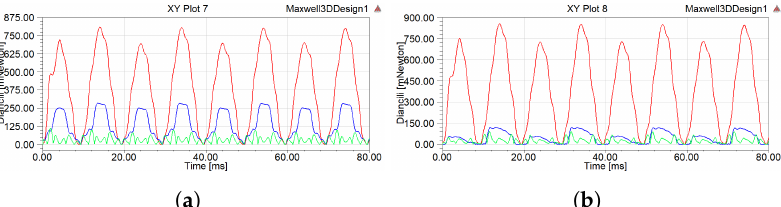
Figure 21. Dynamic response curves of electromagnetic force on each winding under working condition 3. ( a ) The left column. ( b ) The right column.